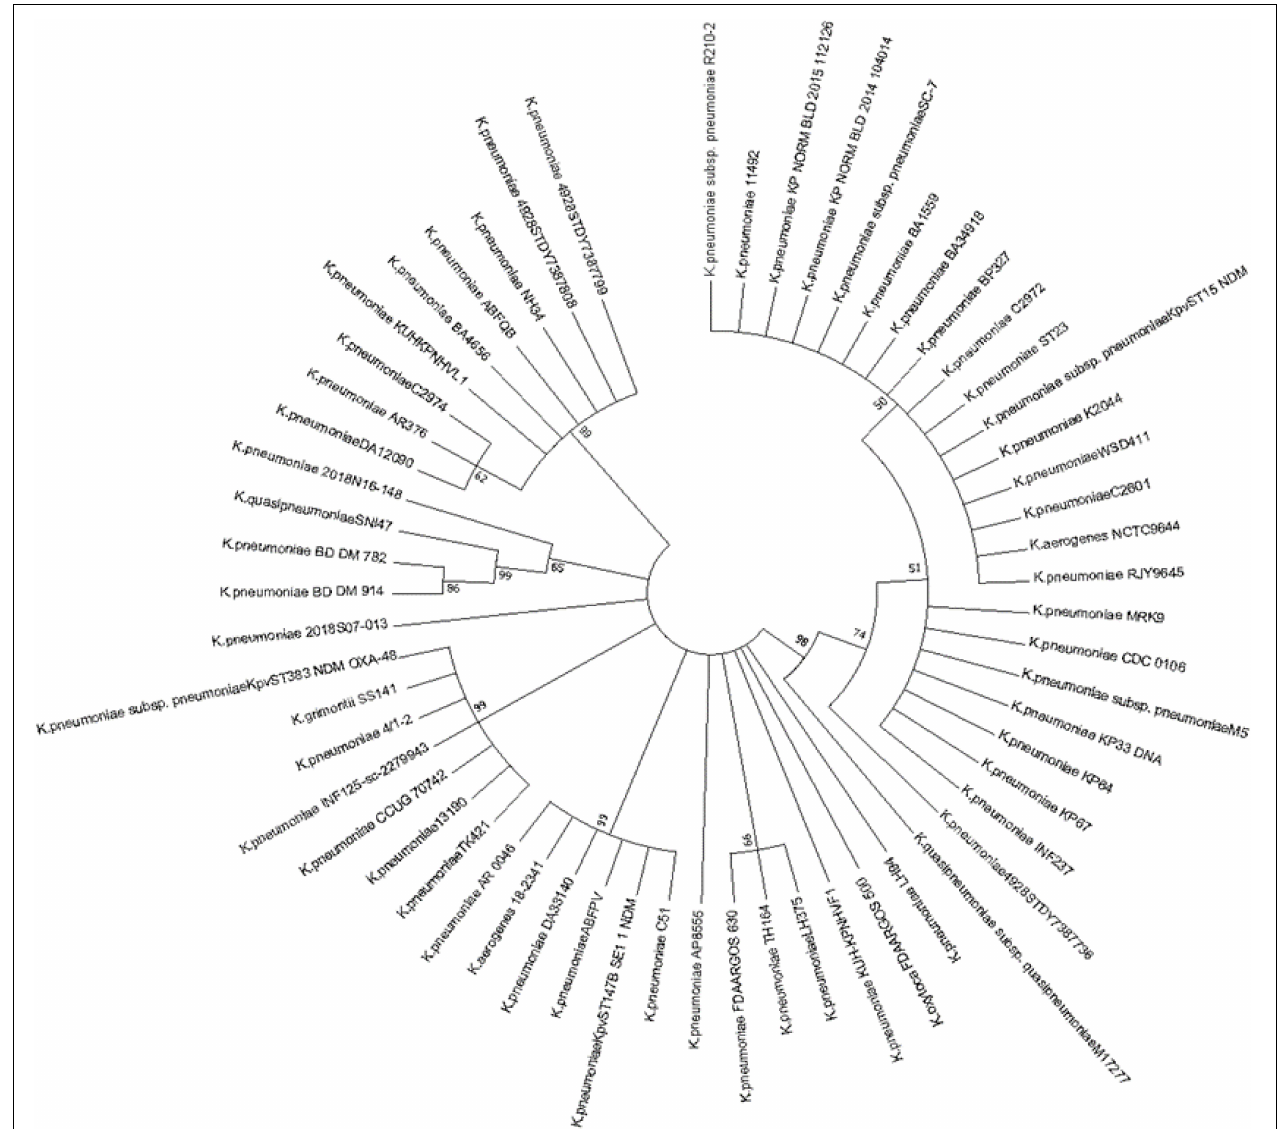
FIGURE 3 | The evolutionary tree of Cas1 of all strains. The Cas1 has 57 strains, respectively. The Cas1 genes sequence were obtained by searching for the complete genome sequences in Genbank. Strains in one branch indicate most evolutionary similarities, the branch represented that these sequences could be divides into groups by certain values and the percentage of each branch showed the sequence similarity, and the evolutionary distance scale of Cas1 in 0.10.